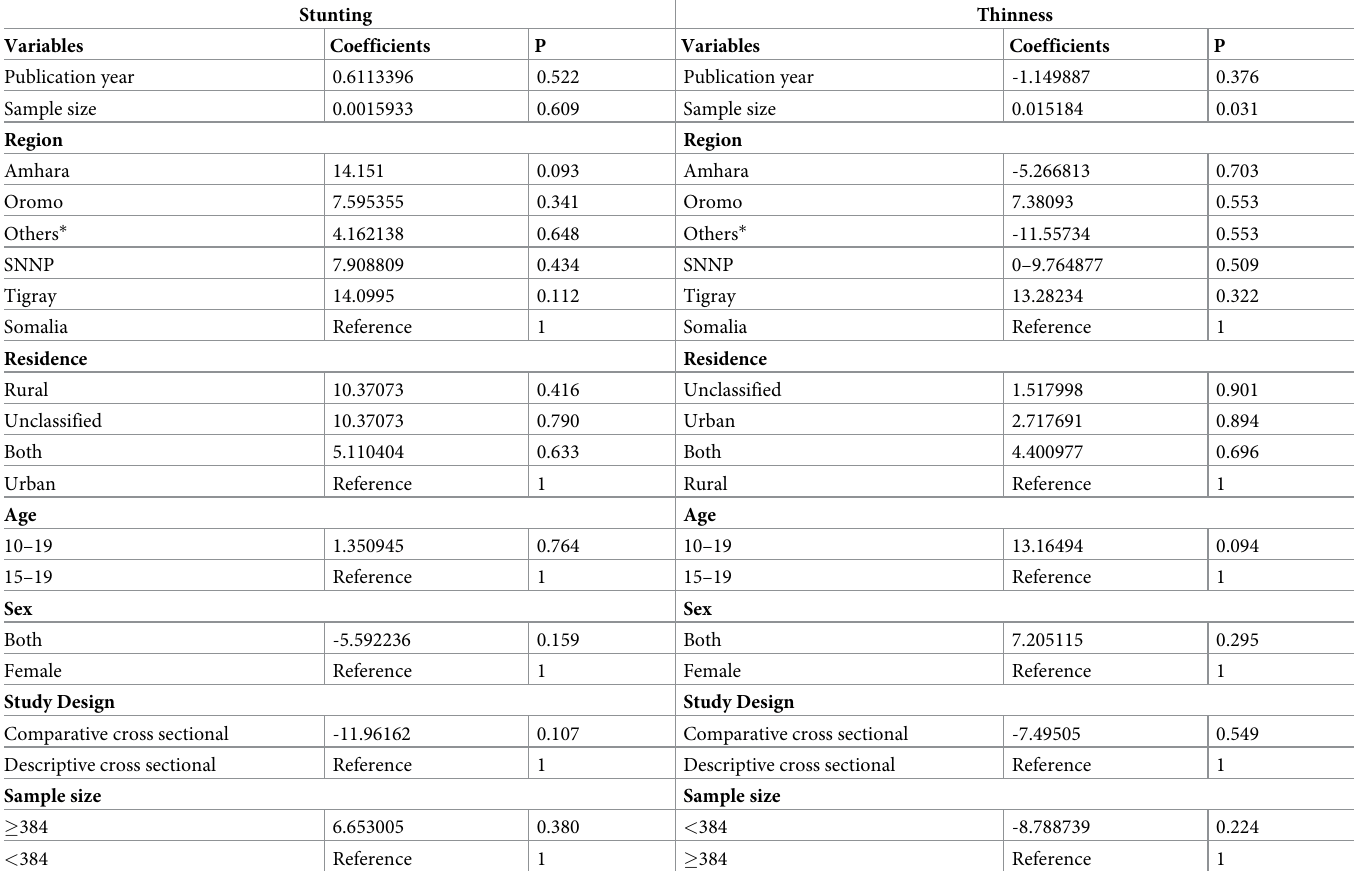
Table 5. Meta-regression for factors related to heterogeneity of adolescent malnutrition in Ethiopia.